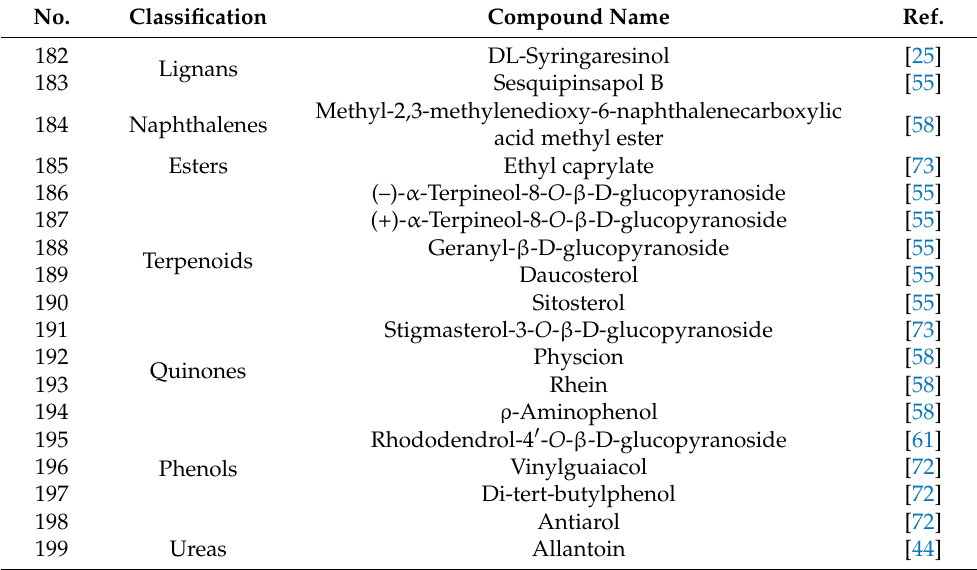
Table 6. Other components in Ephedra sinica Stapf (structural formulas are shown in Figure